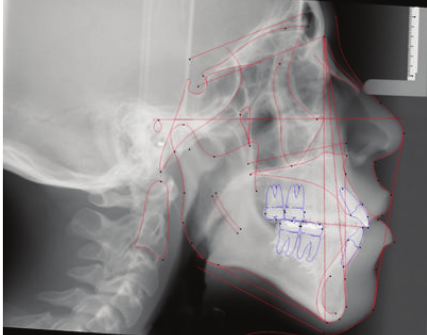
Figure 19: Stage 2: Orthodontic Treatment Final Cephalometric